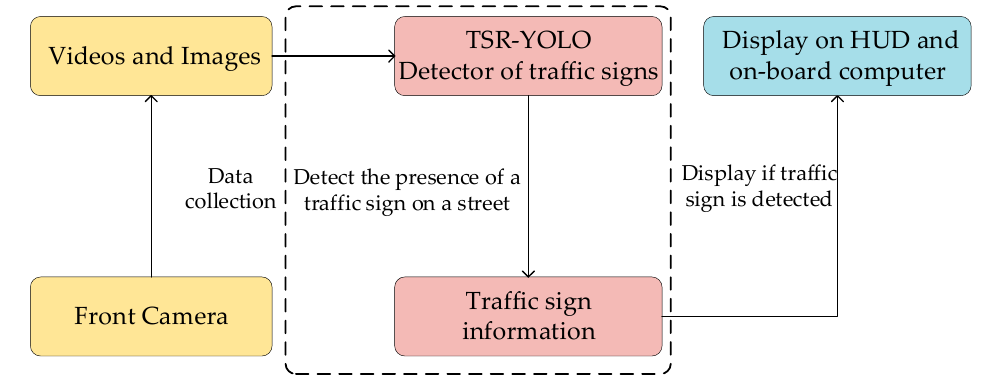
Figure 1. Traffic sign recognition system.